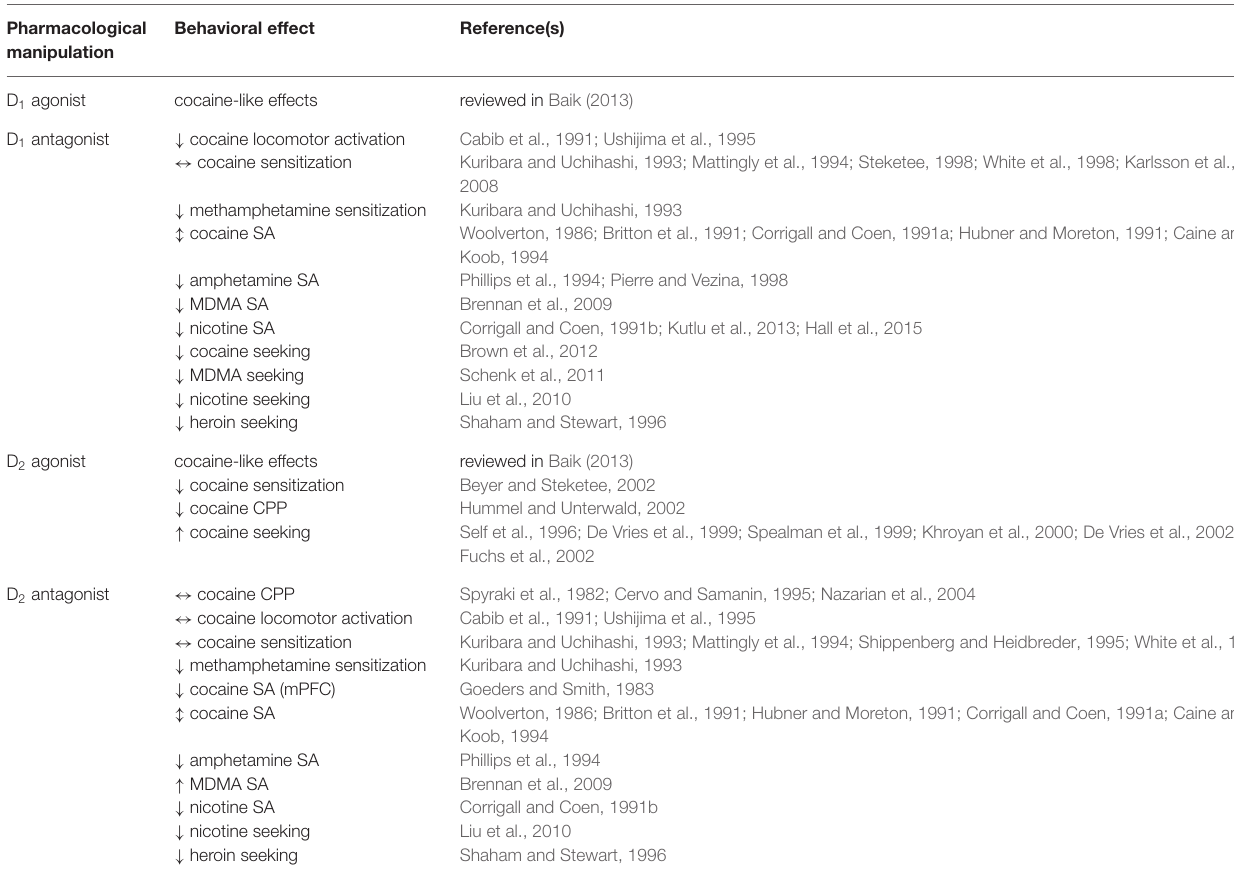
TABLE 1 | Behavioral effects of drugs targeting dopamine